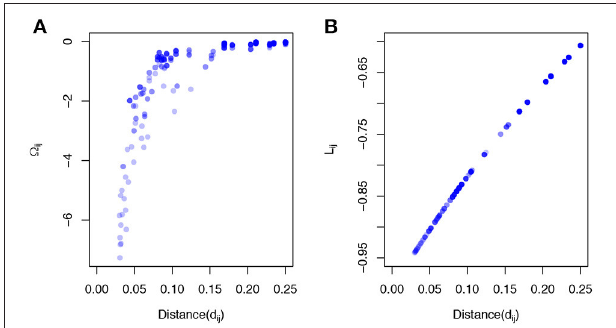
FIGURE 1 | Local smoothing effects of the proposed smoothness penalty. The data was generated based on a simulated phylogenetic tree ( p 200,“rcoal” from R “ape” package). The correlation C ( α ) was calculated = based on the pairwise patristic distances with α inverse correlation matrix ( (cid:127) ij ) are plotted against pairwise patristic distances ( d ij ). (B) The elements of Laplacian matrix ( L ij ) are plotted against pairwise patristic distances ( d ij